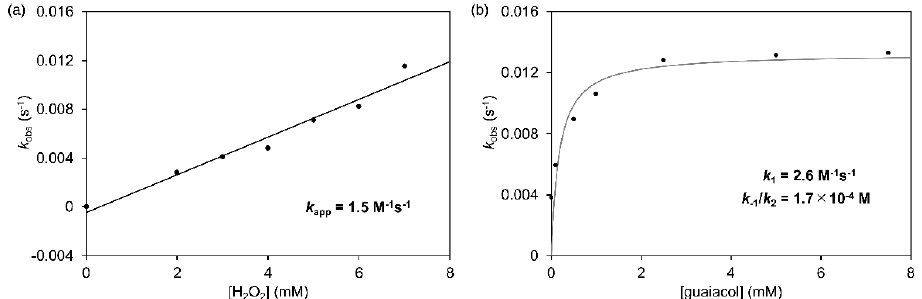
Figure 10. Plots of k obs versus concentration of hydrogen peroxide ( a ) and guaiacol ( b ). For further validation of the proposed reaction mechanism, phenol and other phenol derivatives, p -methoxyphenol, p -methylphenol and p -chlorophenol, were employed as re-